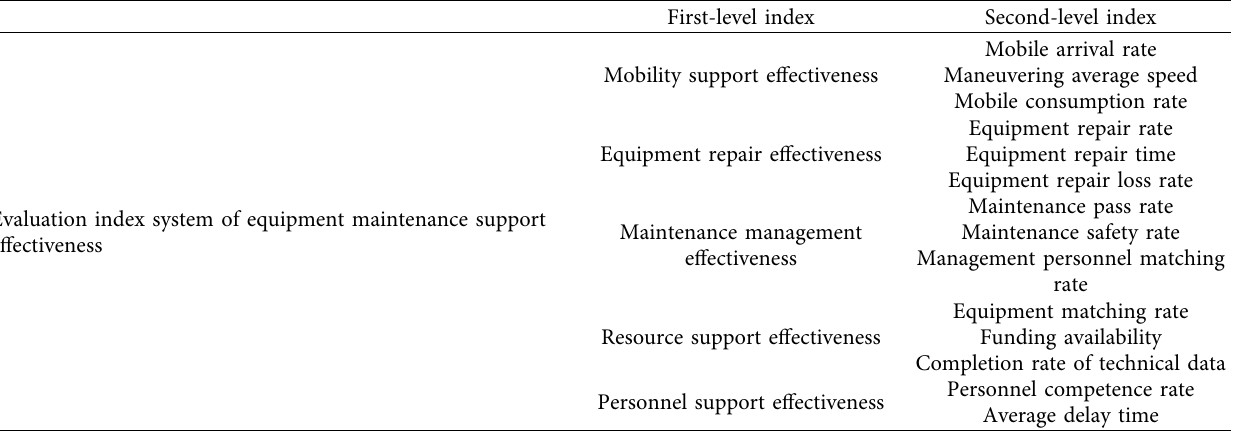
Table 1: Index system of equipment maintenance support